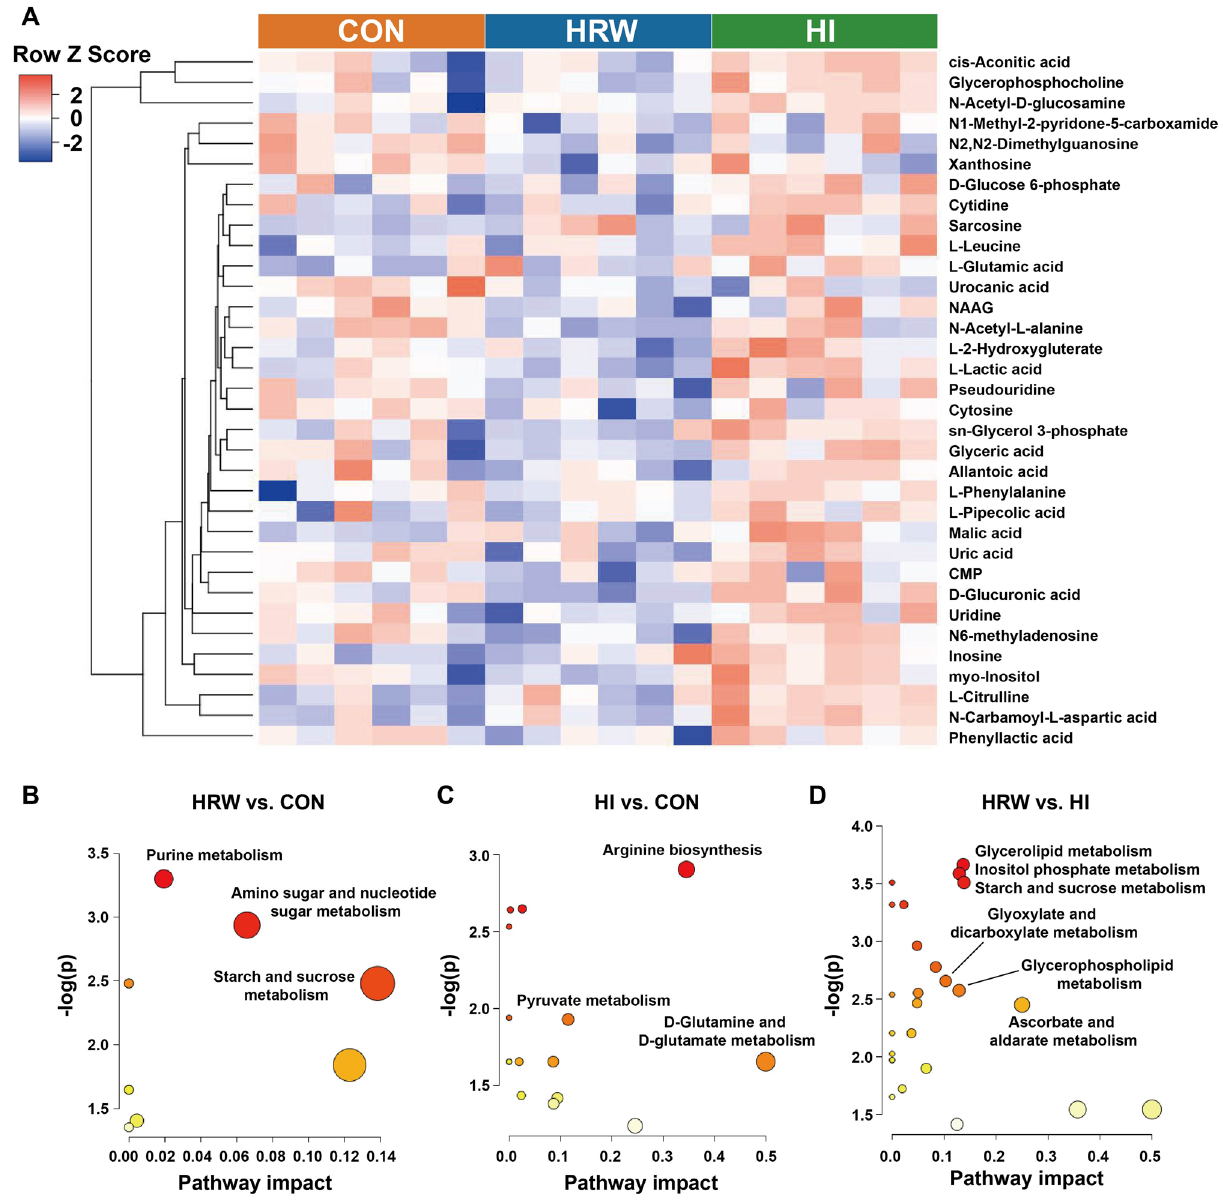
Figure 3. Analysis of differential metabolites in plasma samples among three groups. ( A ) The hierarchical clustering results for differential metabolites. ( B – D ) The functional enrichment analysis for differential metabolites between two groups. NAAG N -Acetylaspartylglutamic acid, CMP Cytidine 5 ′ strongest correlation with Bacteroides (r = 0.944, p < 0.0001). l-lactic acid showed comparable moderate positive correlations with Desulfovibrio and Bacteroides . N -Acetyl-l-alanine and N -Acetyl-d-glucosamine also showed moderate positive correlation with Bacteroides and Elusimicrobium . d-Glucose 6-phosphate showed moderate negative correlations with Elusimicrobium , Clostridium XI , and Barnesiella . Figure 6B showed the Spearman’s correlation analysis between HI and the control group, malic acid had the strongest correlation with Blautia (r = 0.879, p = 0.0002). l-leucine showed moderate positive correlation with Blautia . N -Carbamoyl-l-aspartic acid, cis-Aconitic acid, and inosine also showed moderate positive correlations with Paraprevotella . N -Carba- moyl-l-aspartic acid showed moderate negative correlation with Bifidobacterium . Figure 6C showed the Spear- man’s correlation analysis between HRW and HI group, l-phenylalanine showed high positive correlations with Sphingomonas (r = 0.866, p = 0.0003), Methylocacterium (r = 0.921, p < 0.0001), and Bosea (r = 0.848, p = 0.0005). Glyceric acid also showed high positive correlations with Lactobacillus (r = 0.937, p < 0.0001) and Mycoplasma (r = 0.881, p = 0.0002). N6-methyladenosine showed high positive correlation with Lactobacillus (r = 0.895, p < 0.0001), while had strong negative correlation with Methanosphaera (r = − 0.834, p = 0.0007).